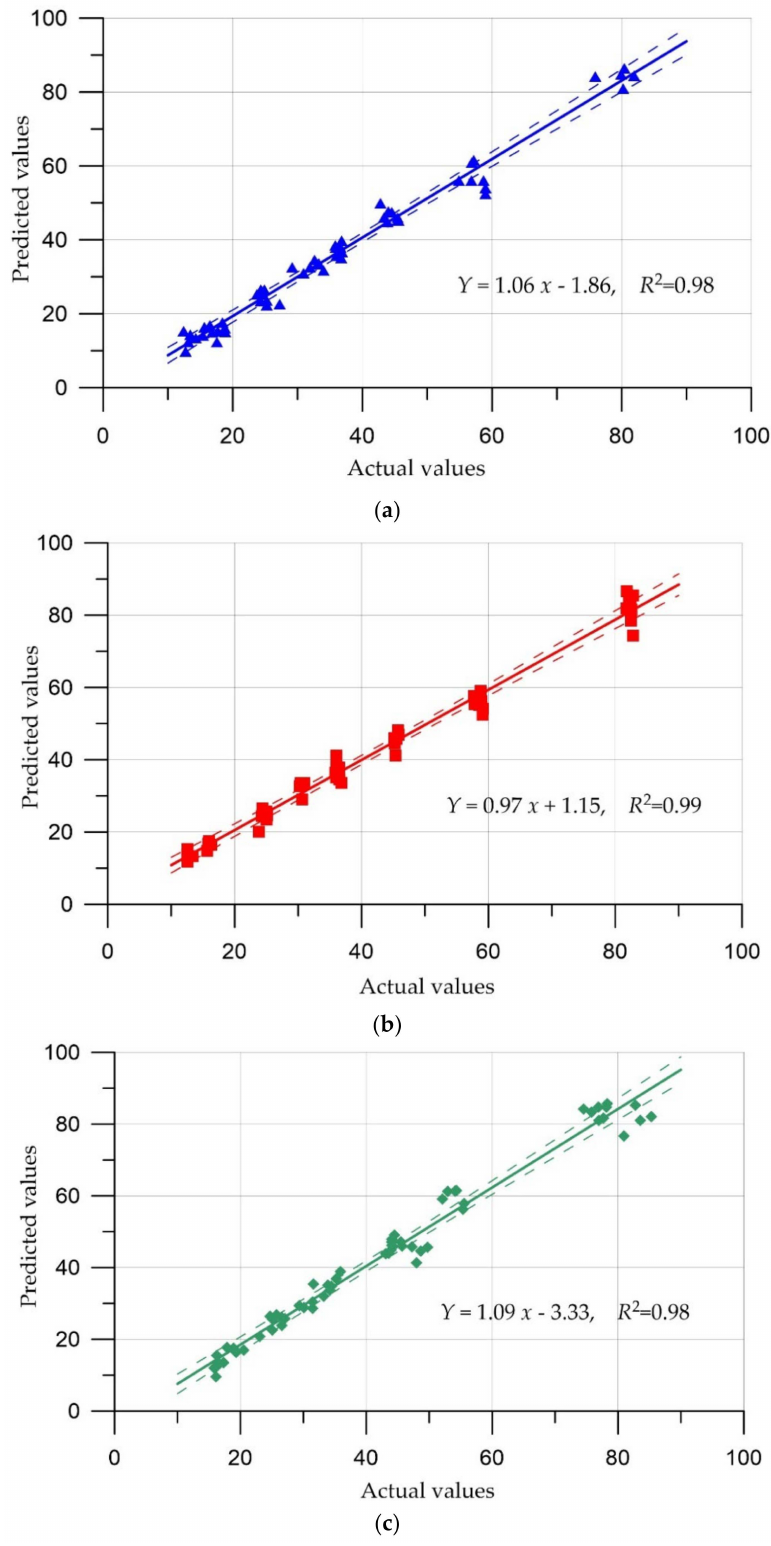
Figure 8. Relationship between actual compressive strength and calculated values ( a ) for the CatBoost model; ( b ) for the k-nearest neighbors model; ( c ) for the SVR